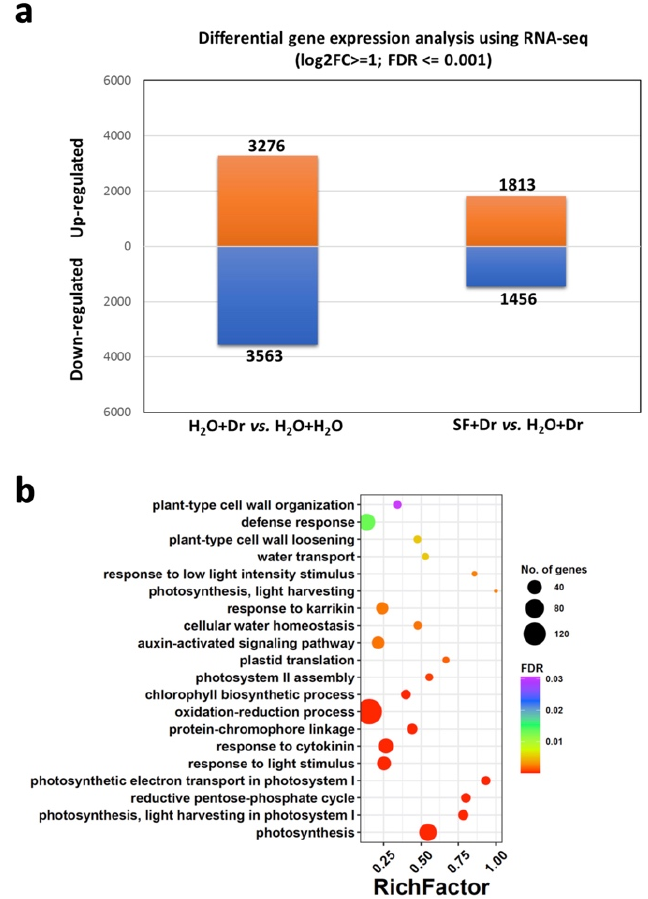
Figure 3. SF priming-induced transcript changes during drought stress in Arabidopsis. ( a ) Number of differentially expressed genes (DEGs) in stressed (H 2 O+Dr) vs. unstressed (H 2 O+H 2 O), and in primed (SF+Dr) vs. unprimed (H 2 O+Dr) plants during drought. The list of DEGs is provided in Supplementary File S1. ( b ) Gene ontology (GO) enrichment of DEGs in SF-primed and stressed (SF+Dr) plants categorized into different groups based on the biological process. The RichFactor represents the ratio of the number of DEGs annotated with the given GO term to the number of all genes annotated with the respective GO term. The sizes and colours of the dots represent the number of genes and FDR value, respectively. The list of enriched GO terms is provided in Supplementary File S2. Dr, drought stress; SF, Super